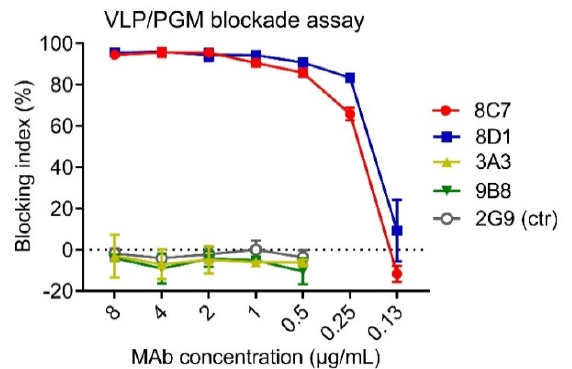
Figure 2. The ability of the mAbs to block the interaction between GII.3-KJ VLP and HBGA-containing PGM III was tested by ELISA. HBsAg-specific mAb 2G9 was used as a control (ctr). Blocking index (%) was determined by comparing the results of the VLP/MAb wells with the VLP-only wells. Data are mean ± SD of triplicate wells.